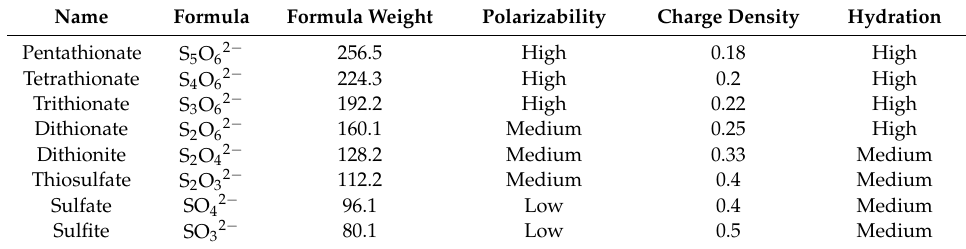
Table 4. Predicted selectivity of the resin for sulfur-oxygen anions presented in declining order.